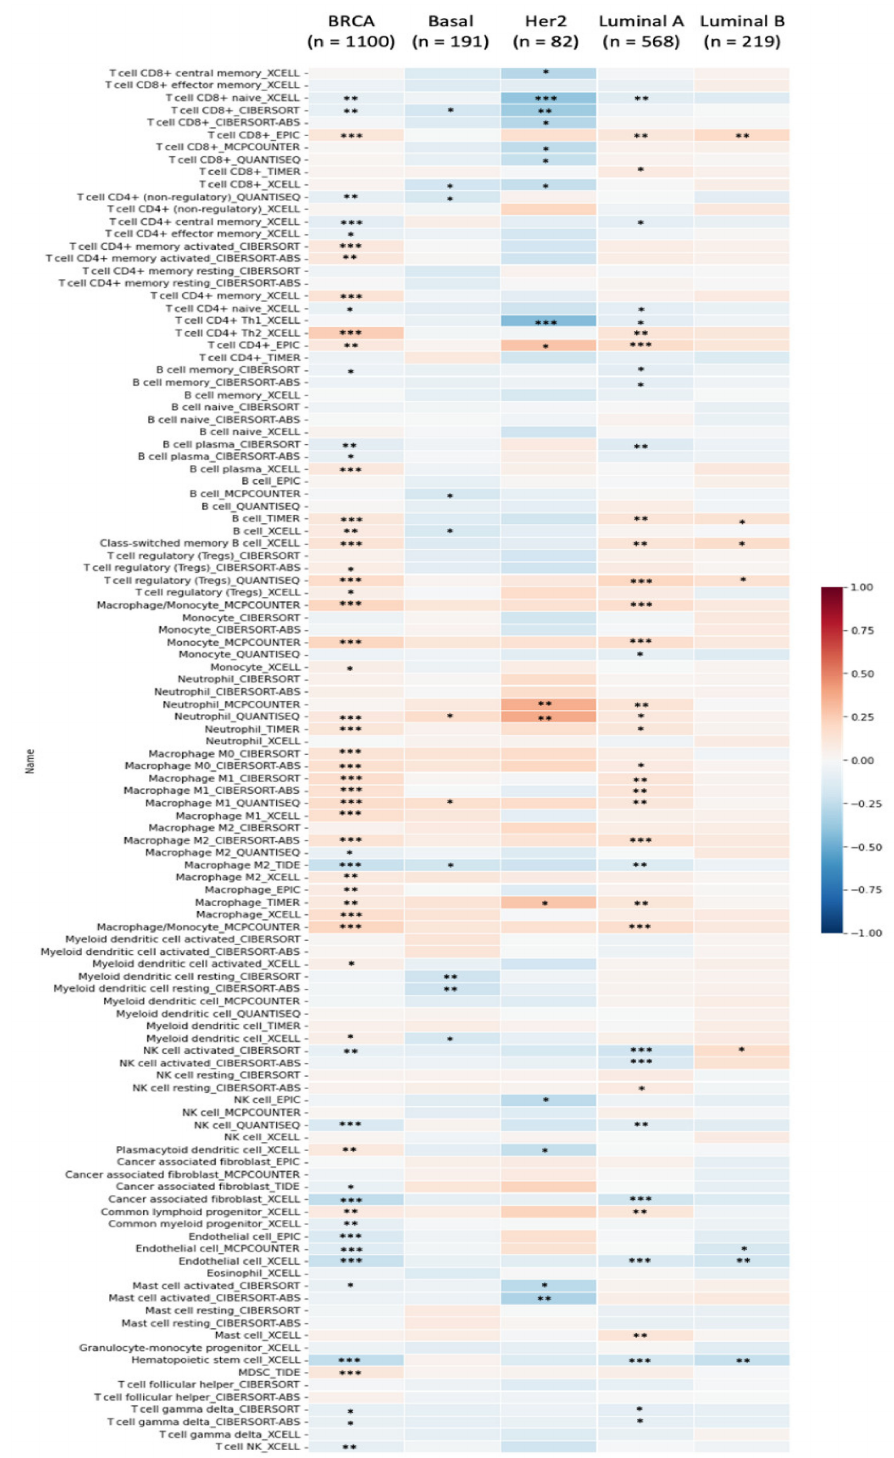
Figure 9. Solute carrier 35A (SLC35A2) expressions and immune infiltration in several BRCA subtypes are depicted in a heatmap. The plot shows correlations between BRCA subtypes (luminal A, luminal B, HER2, and basal) while six cutting-edge algorithms (including quanTIseq, CIBERSORT, MCP-counter, EPIC, xCell, and TIMER) were used to determine the number of samples from 112